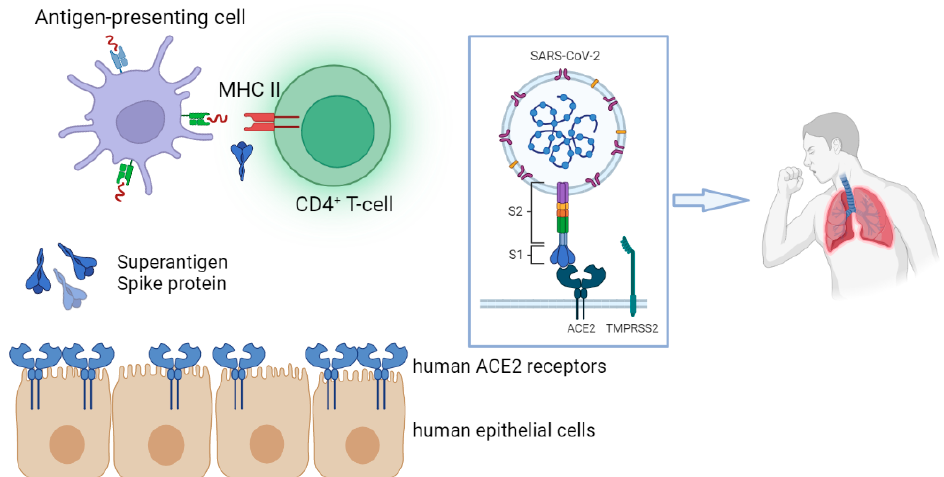
Figure 1. The spike (S) protein of SARS-CoV-2 may act as a superantigen, triggering a cytokine storm that contributes to the development of MIS-C. Superantigens interact directly with the invariant region of the class II MHC molecule, bypassing the need for an antigen-presenting cell-mediated phase. The figure was originally designed by the Biorender in silico tool (https://biorender.com, accessed on 14 January 2023).